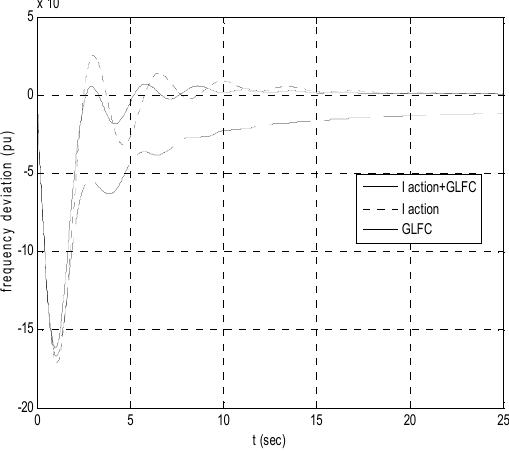
Figure 7. The tie line power deviation response. (At step load change of 187.5MW in area 1).